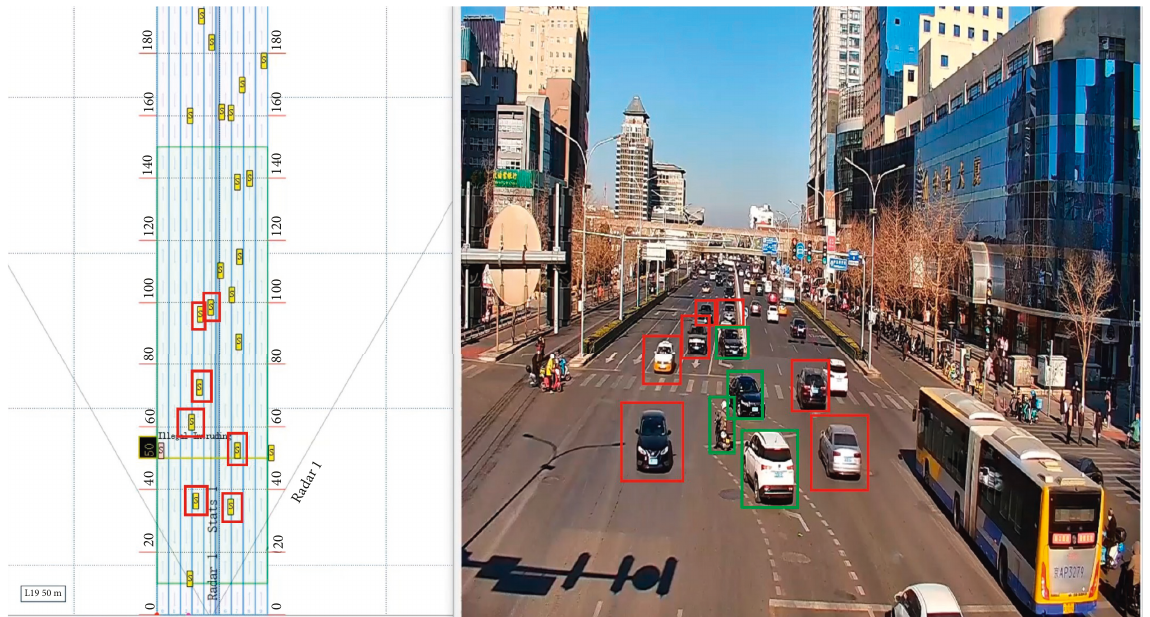
Figure 12: Tracking result of radar.